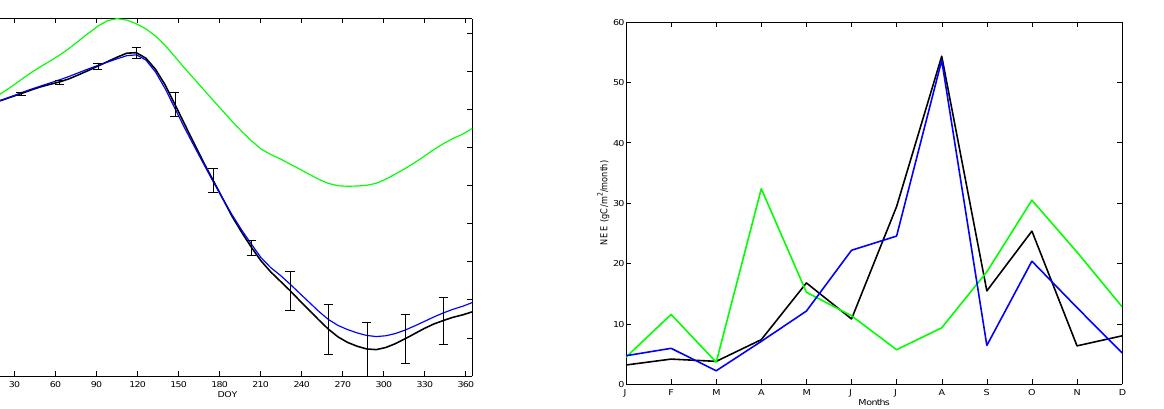
Figure 9. Standard deviations over 2001–2004 of the monthly NEE for the observations (black curve), for the model run with the stan- dard parameter set (green curve), and with the 2001–2004 inverted parameter set ( X 4 Y , blue